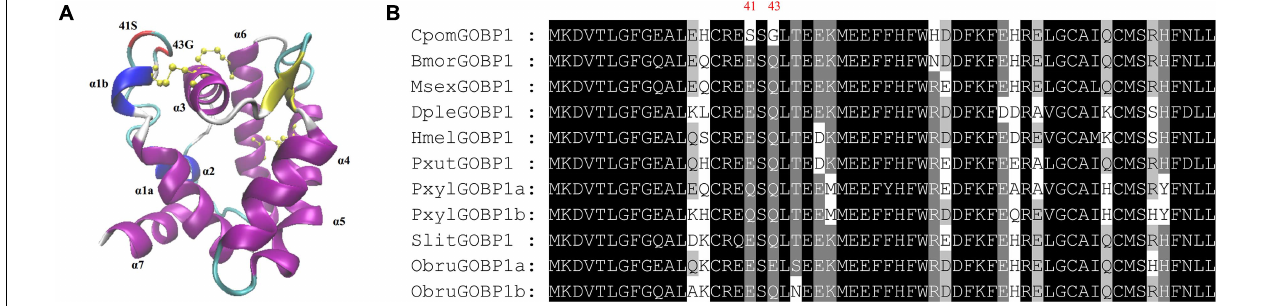
FIGURE 6 | Structural homology model and positively selected sites of C. Pomonella GOBP1. (A) Structural homology model of C. pomonella GOBP1, positively selected sites are marked in red. (B) Multiple sequence alignments of GOBP1 genes from ten moth species.